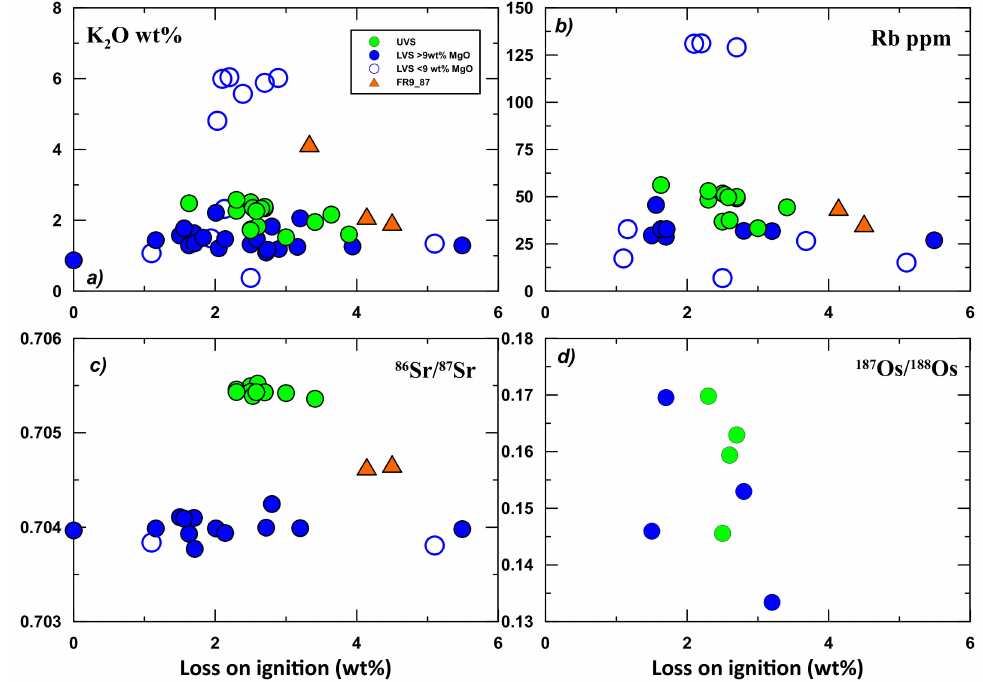
Figure 4. Loss on Ignition (LOI) values for Christmas Island high MgO lava (>9 wt%) and low MgO lava (<9 wt%) (Table S5) and dredged lava from the VMP by the RV Franklin during voyage FR9_87 (Table S5) versus ( a ) K 2 O wt%; ( b ) Rb ppm; ( c ) 87 Sr/ 86 Sr values (Table 2, [10,43]), ( d ) 187 Os/ 188 Os values (Table